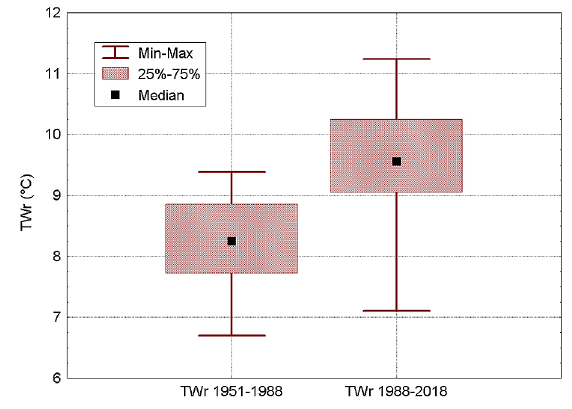
Fig. 4. Variation ranges of the annual air temperature in Wrocław (TWr) in both periods: 1951–1988 and 1988–2018. It appears noteworthy that in the second period, the lower limit of the second quartile is higher than the upper limit of the third quartile in the previous period, and the median in the second period is above the absolute maximum in the first